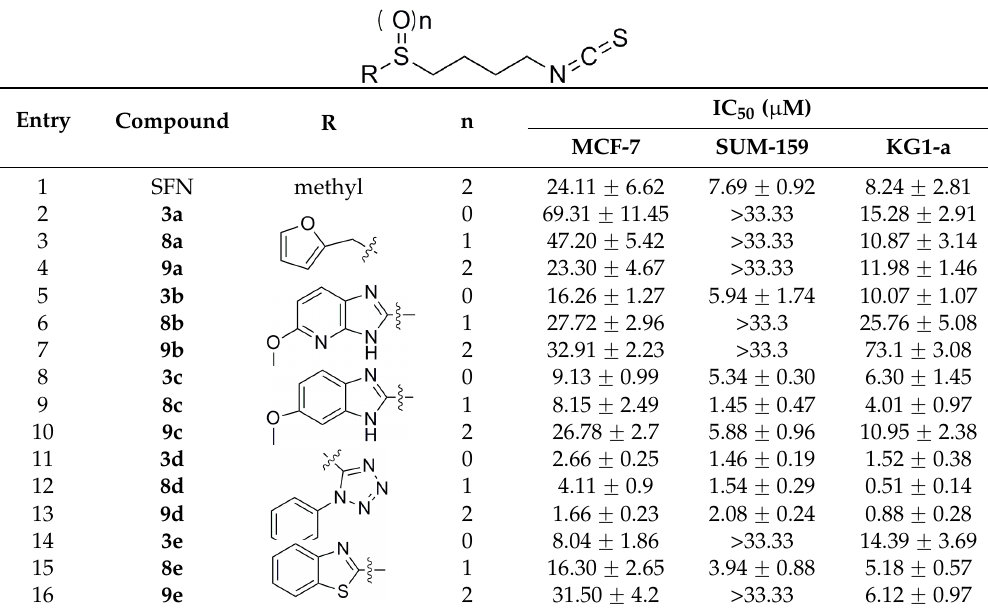
Table 2. Inhibitory effects (IC 50 ) of water soluble compounds 14a – c on MCF-7, SUM-159 and KG-1a cell lines.